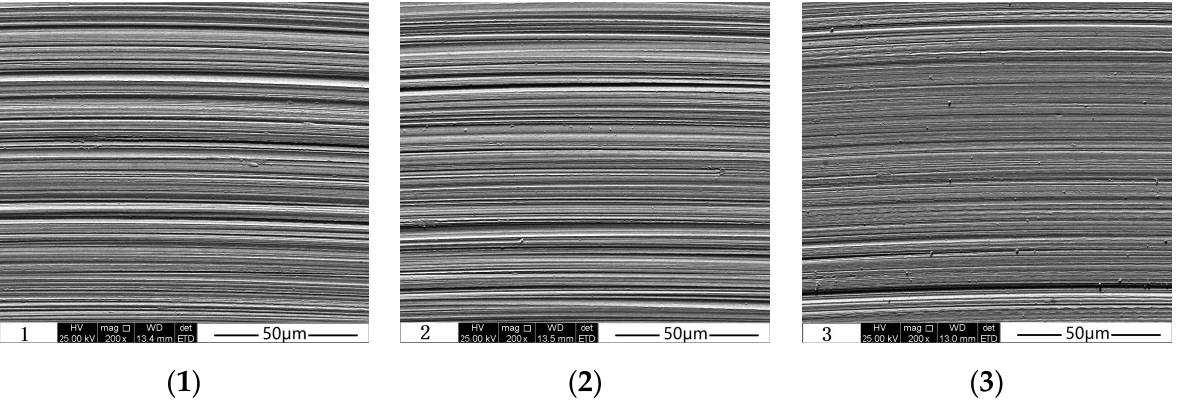
Figure 13. Wear morphology of pin and disc, ( 1 ) High manganese steel, ( 2 ) Medium chromium alloy steel, ( 3 ) High chromium alloy steel.